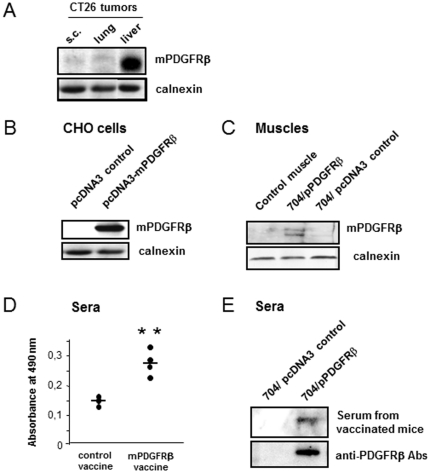
Formulation of DNA with 704 polymer increases mPDGFRβ expression level after intramuscular injection and induces a specific immune response.Western blot analyses of mPDGFRβ expression level (A) in CT26-derived subcutaneous tumors, pulmonary and liver metastases, (B) in pcDNA-3 control (with antisens PCR product) and pcDNA3-mPDGFRβ-transfected CHO cells and (C) in tibialis anterior muscles of Balb/c mice injected once with low-dose (25 µg) of mPDGFRβ encoding plasmid formulated in 704 copolymer (n = 4). (D) Determination of serum levels of mPDGFRβ-specific antibodies by ELISA. Mice were challenged on day 0, and restimulated on day +21, and day +42 with the DNA vaccine (50 µg) or the control vector formulated with 0.3% 704 before being sacrificed two weeks later for serum collection (n = 5). ** p<0.01. (E) Mouse sera were assayed for their ability to react with the band of the purified antigen from the mPDGFRβ-transfected CHO cells by Western blot analysis. Goat anti-mPDGFRβ antibodies from Santa Cruz were used for comparison.